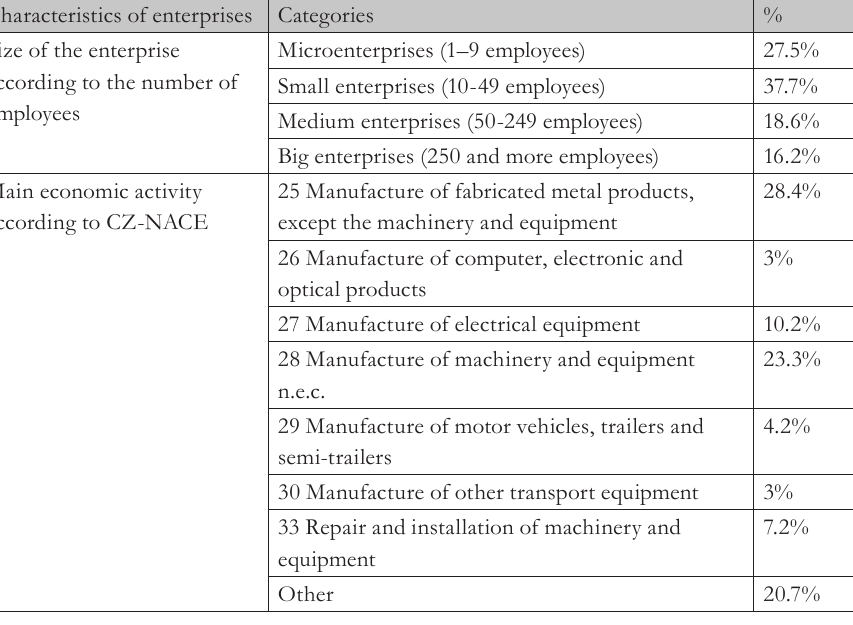
Tab. 1 – Selected characteristics of engineering enterprises. Source: Survey questionnaire Characteristics of